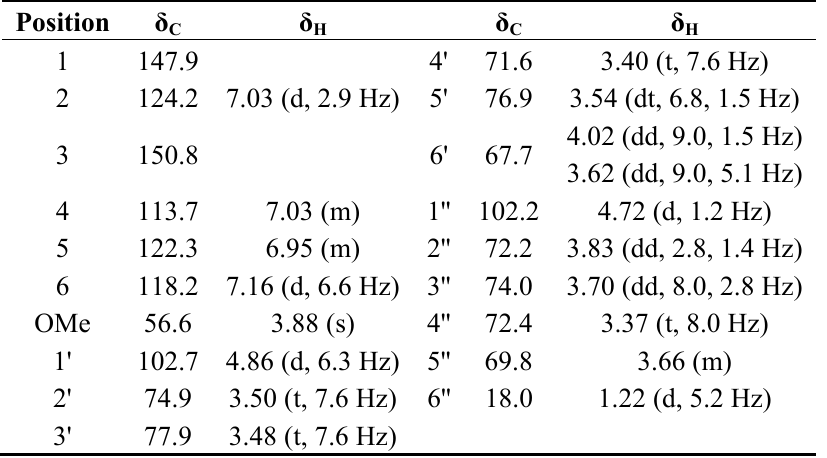
Table 1. 13 C- and 1 H-NMR spectral data of compound 1 ( δ in ppm, J in